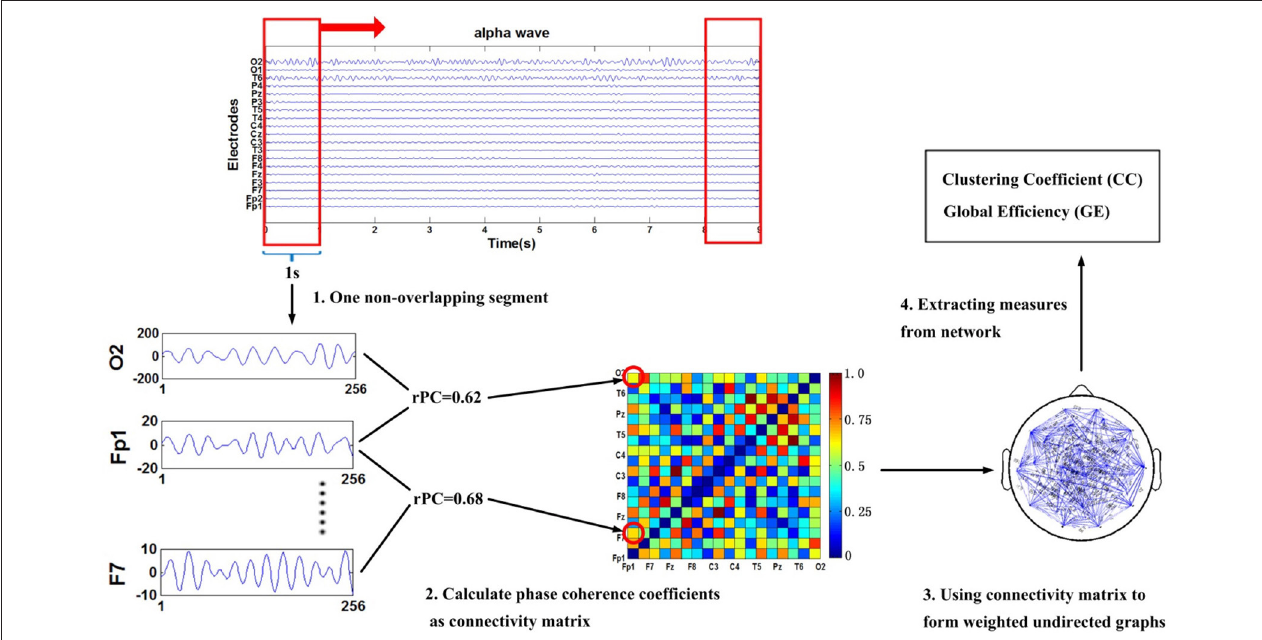
FIGURE 2 | The multi-step illustration of the procedure for extracting networks’ measures from EEG time series to sub-network. To be noted, the EEG series given in this graph are the 10th subject’s resting state data set and the electrode Fp1, F7, and O2 are shown as an example of the phase synchronization coefficients computed between two electrodes in the alpha band. Additionally, the graph is fully connected. Abbreviation: rPC: respective phase